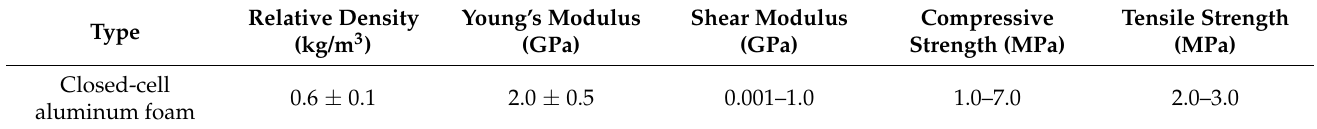
Table 1. Mechanical properties of aluminium foam